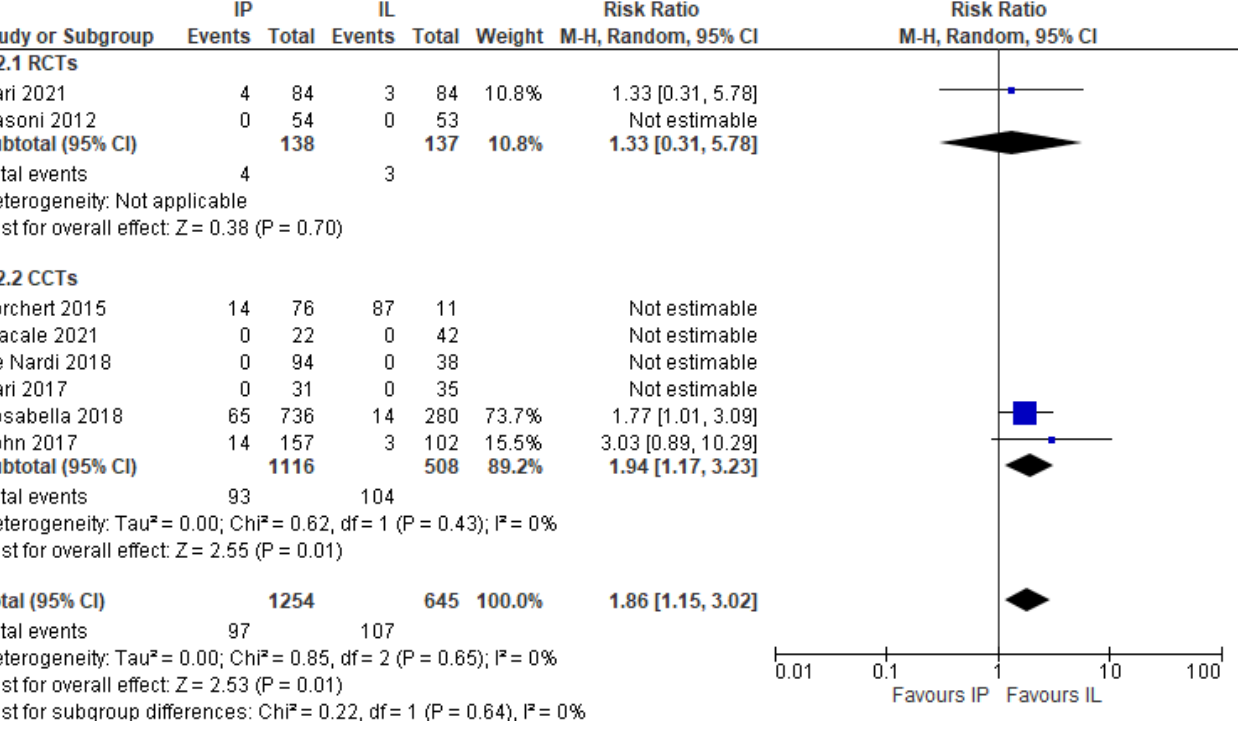
Figure 10. Conversion rate, risk ratio in the laparoscopic subgroup.